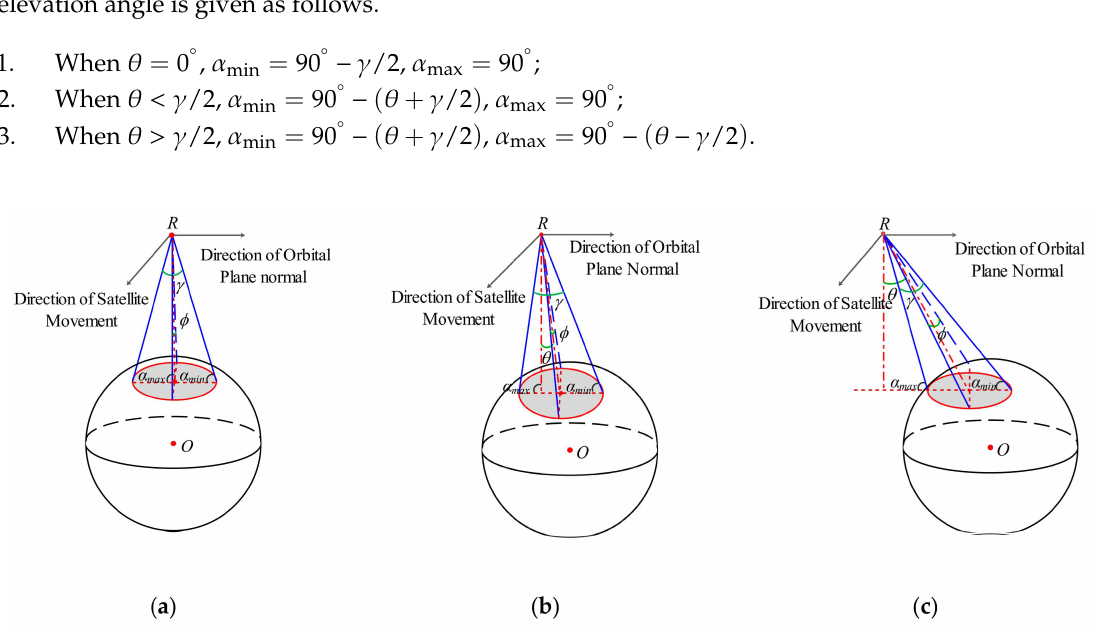
Figure 3. The Geometric relationship between half-power beam width (HPBW) and pointing angle: ◦ ( a ) θ = 0 , ( b ) θ < γ /2, ( c ) θ > γ /2. Where R is the GNSS-R satellite, O is the geo-center, θ is the pointing angle, γ and ϕ are horizontal and vertical HPBW, respectively, α min and α max are represent the maximum and minimum elevation angle. To simplify the analysis, γ = ϕ